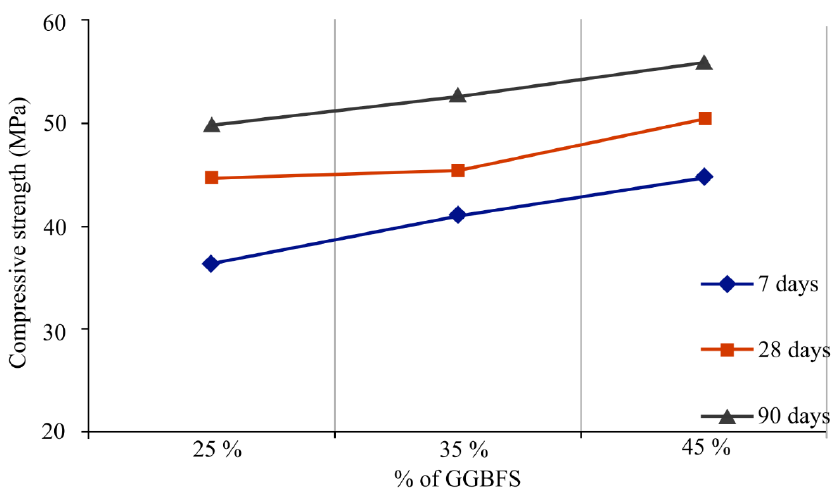
Figure 9. Different content percentages of GGBFS show different compressive strengths [135].